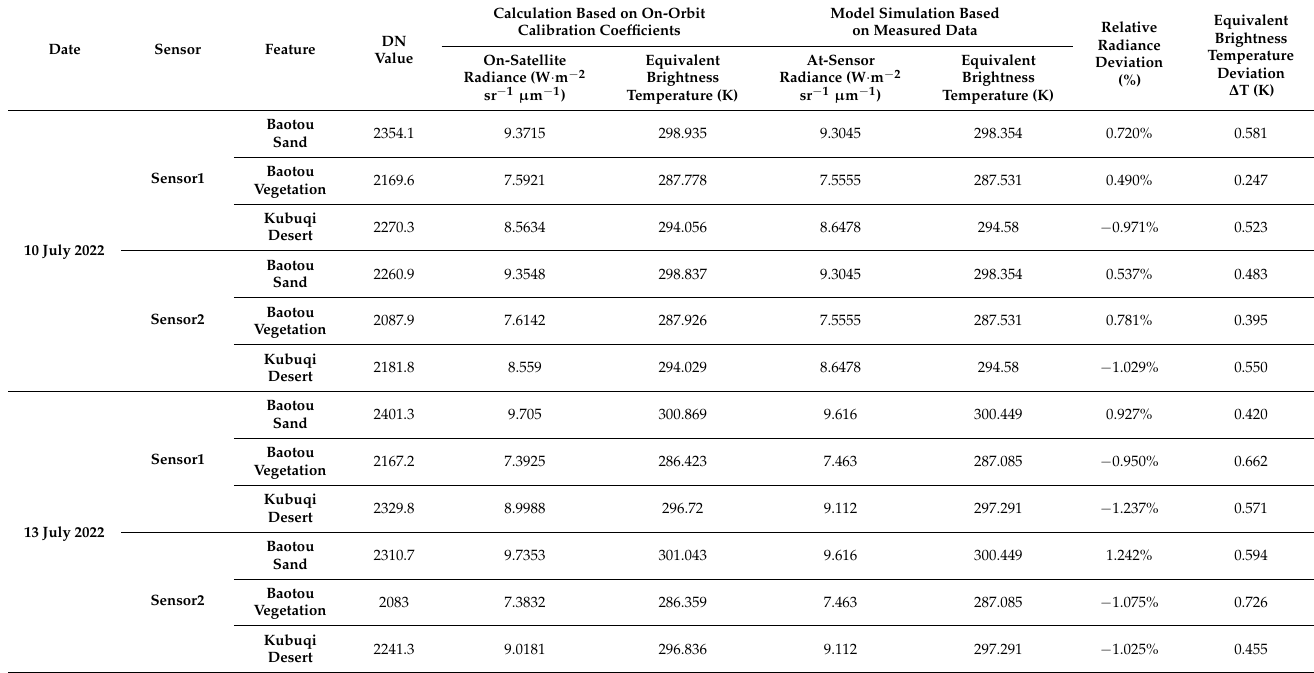
Table 4. On-orbit validation results for the calibration accuracy of ZY1-02E.